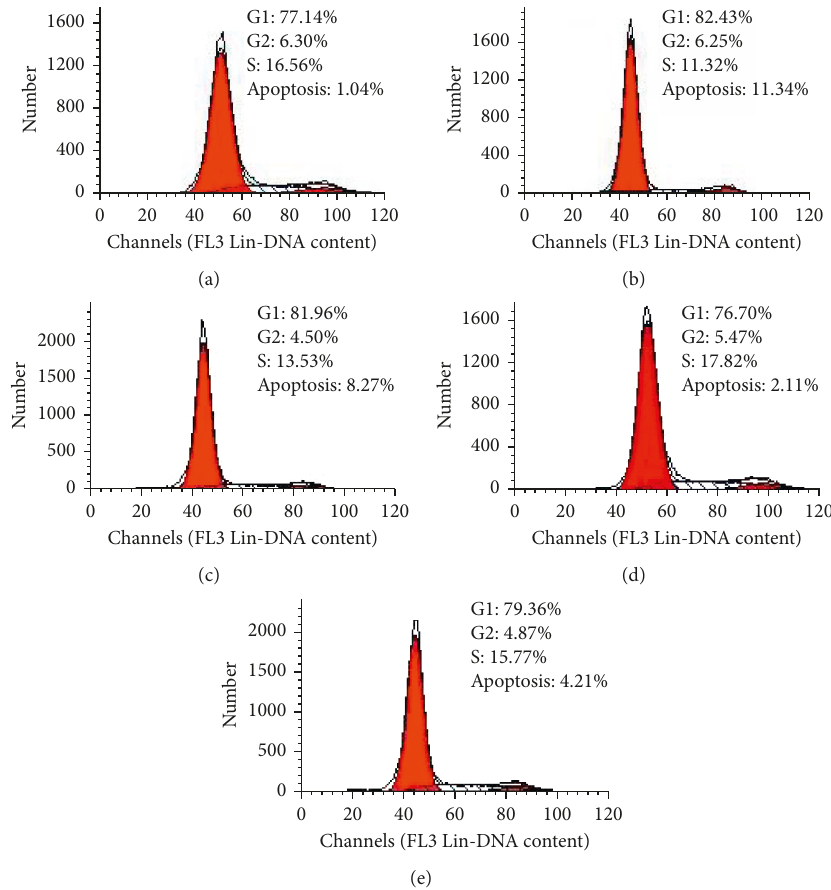
Figure 5: Influence of L-Cys on cell cycle and the apoptosis rate of A549 cell damaged by acetaldehyde. (a) Control; (b) 200 μ mol/L acetaldehyde; (c) 40 μ mol/L L-Cys+acetaldehyde; (d) 160 μ mol/L L-Cys+acetaldehyde; (e) 640 μ mol/L